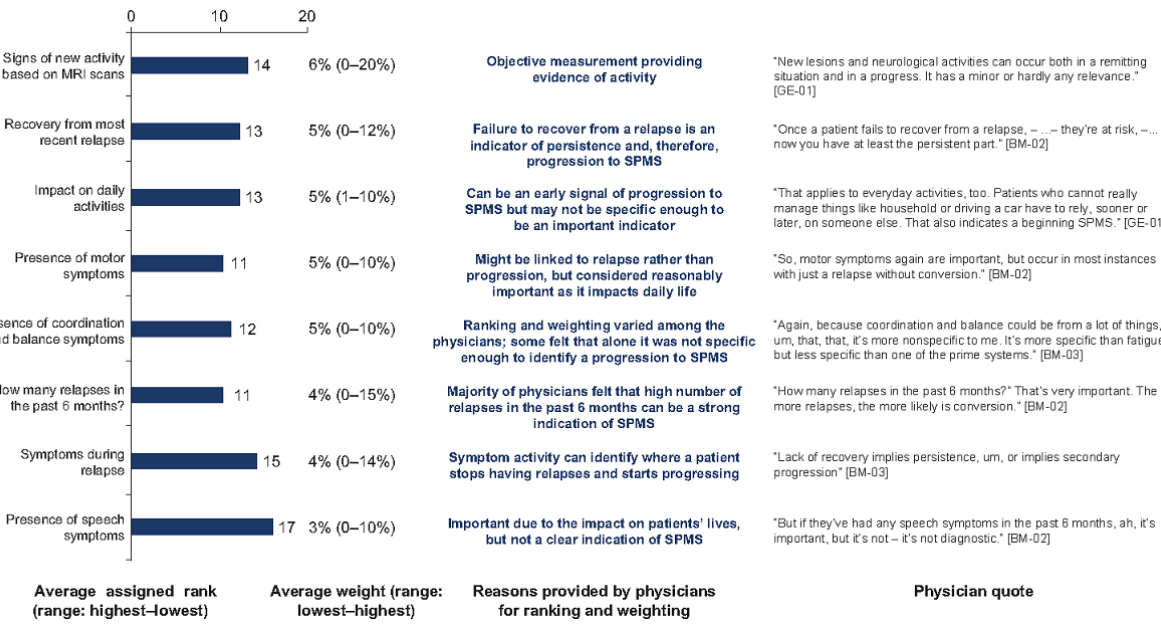
Figure 5. Variables of moderate importance in progression to secondary progressive multiple sclerosis. Ranking out of 26 variables included. Lower ranking indicates greater importance. MRI: magnetic resonance imaging; SPMS: secondary progressive multiple